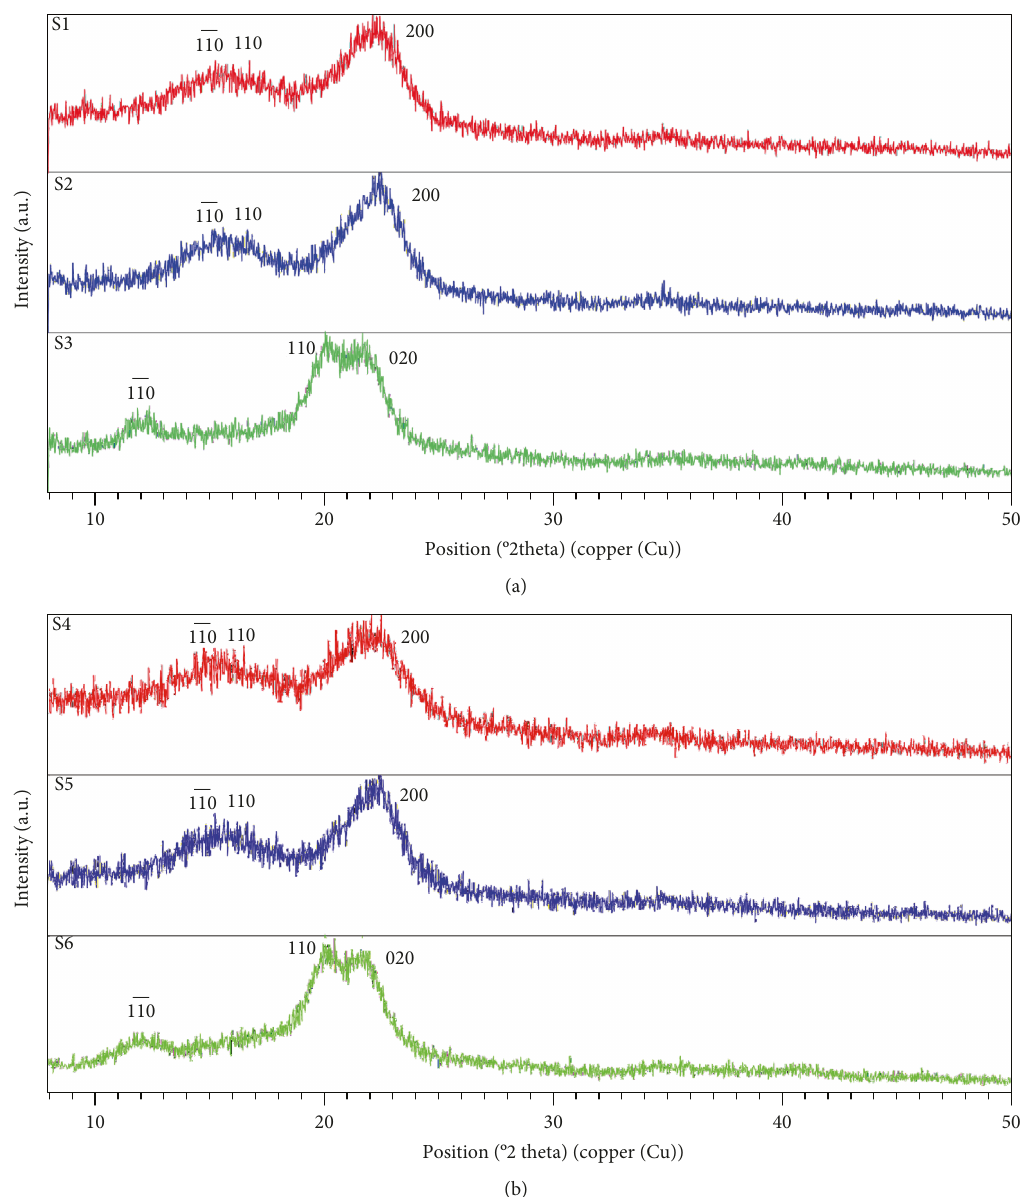
Figure 4: Characteristic XRD patterns of fi llers ((a) white willow-based fi llers, (b) black alder-based fi llers; S1 (S4): extracted wood; S2 (S5): holocellulose; S3 (S6): alpha